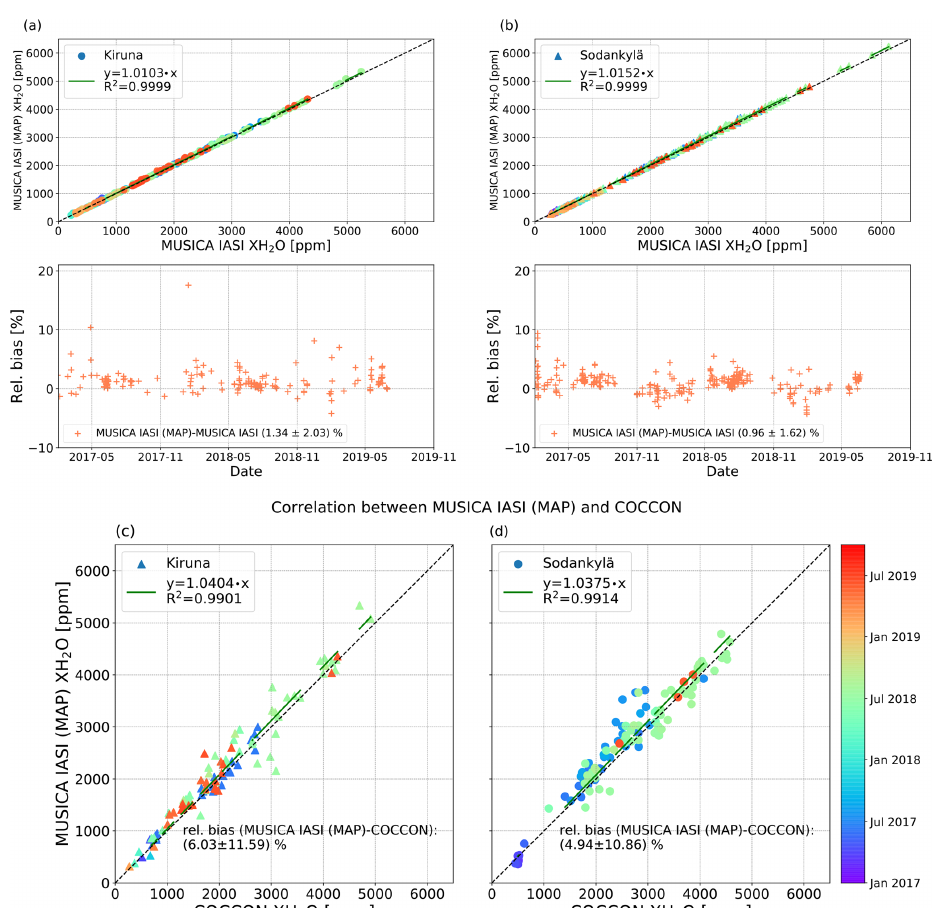
Figure 11. Correlation plots of MUSICA IASI XH 2 O and MUSICA IASI (MAP) and time series of their relative difference at the Kiruna site (a) and the Sodankylä site (b) , and correlation plots of COCCON XH 2 O and coincident MUSICA IASI (MAP) retrievals at the Kiruna site (c) and the Sodankylä site (d) . The annotations follow those in Fig. 2.